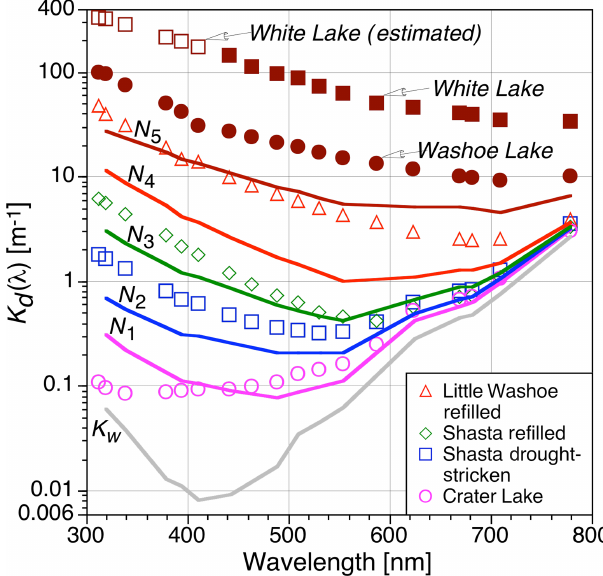
Figure 10. The centered K d (λ) spectra of the five classes ( N i ) de- termined from an objective FCM classification of the data presented in Figs. 3–8 with a few omissions for data consistency (e.g., White Lake, Bear Lake, ship-induced resuspension) and shown with re- spect to K w . Example K d spectra from drought-stricken and re- filled lakes plus Crater Lake, obtained by averaging the results from multiple optical casts, are also shown to demonstrate the more than 3 decades of dynamic range in turbidity that were sampled. The shorter wavelengths for White Lake (open dark red squares) re- quired individual wavelength processing to provide the estimated K d values, whereas all other data were obtained with a single pro-